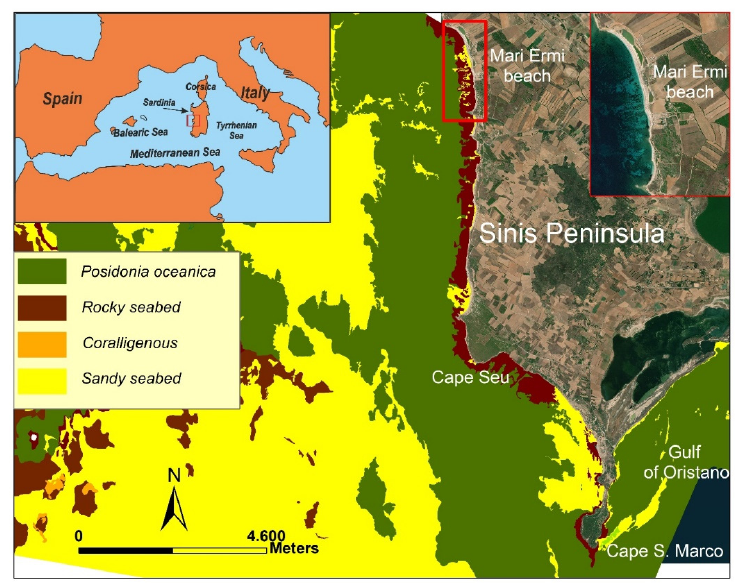
Figure 1. Study area. Inset map showing Mari Ermi Beach.